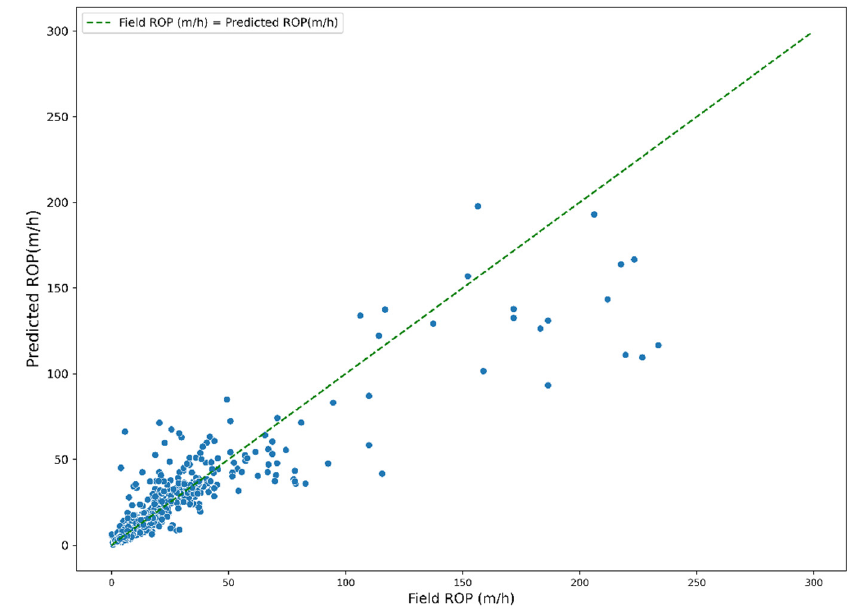
Figure 15. Measured vs predicted ROP by random forest regressor .